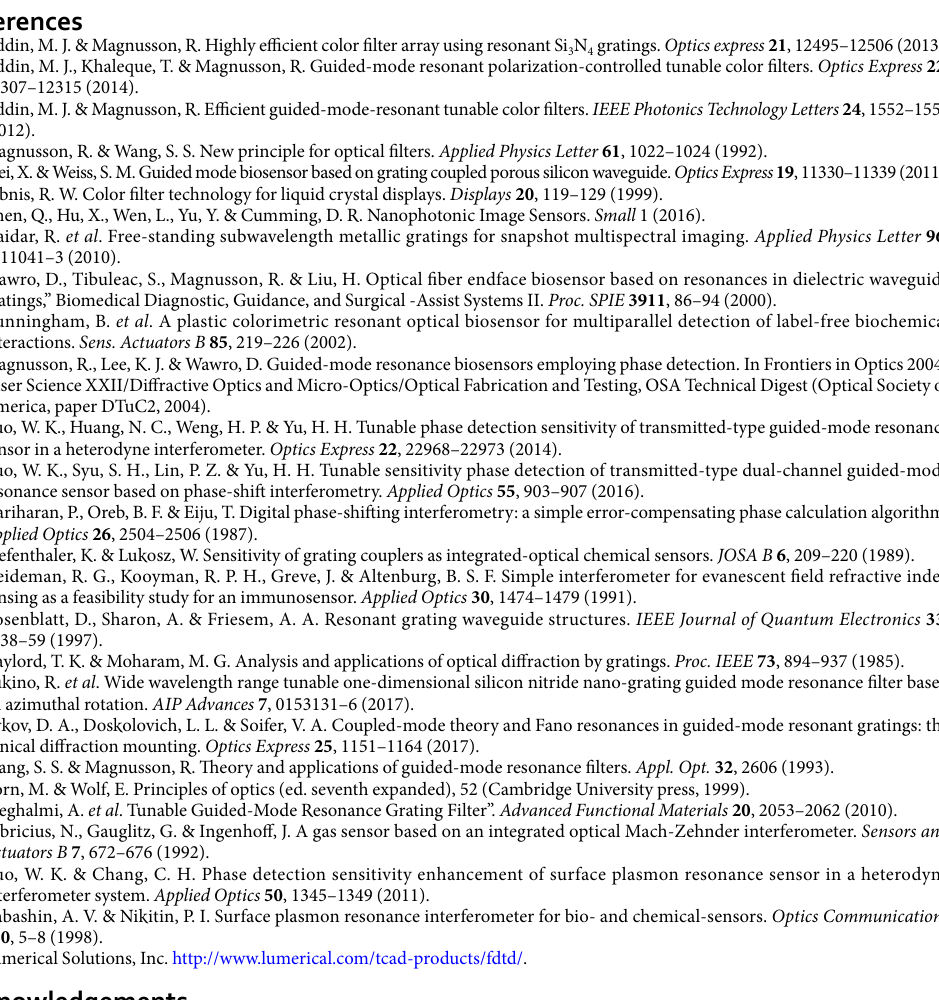
Figure 3 schematic design. The schematic of the experimental setup shown in Fig. 3 is drawn using Google SketchUp Make 2017 (available at